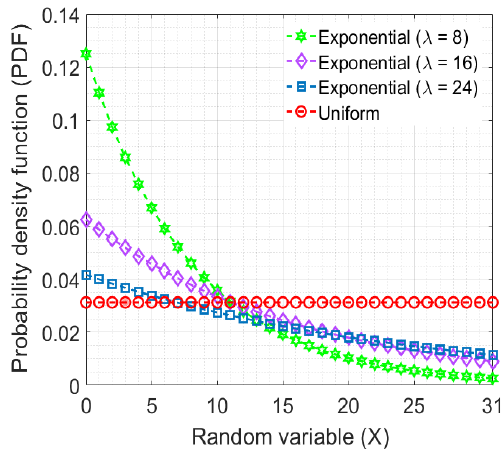
Figure 2. Uniform distribution-based and Poisson process-based (that is, exponential with λ = 8,16,24) random value